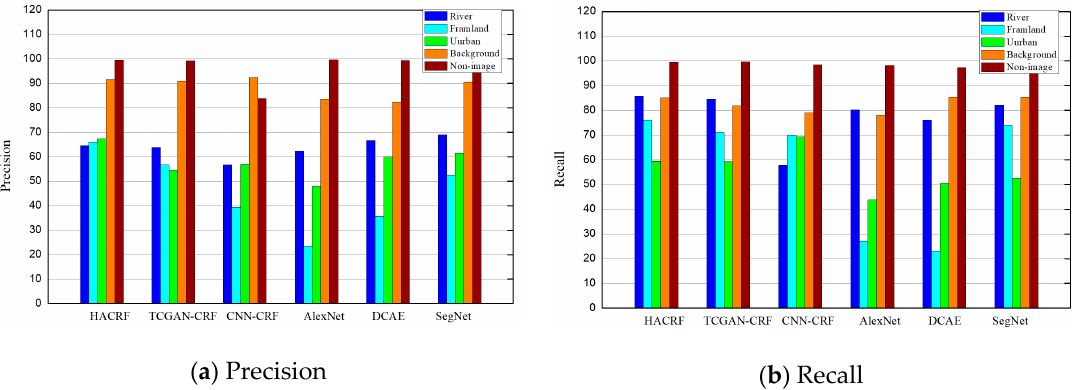
Figure 6. Comparison of the pixel-wise precision and recall for individual classes of superpixels with five state-of-the-art algorithms. ( a ) pixel-wise precision; ( b ) pixel-wise recall.